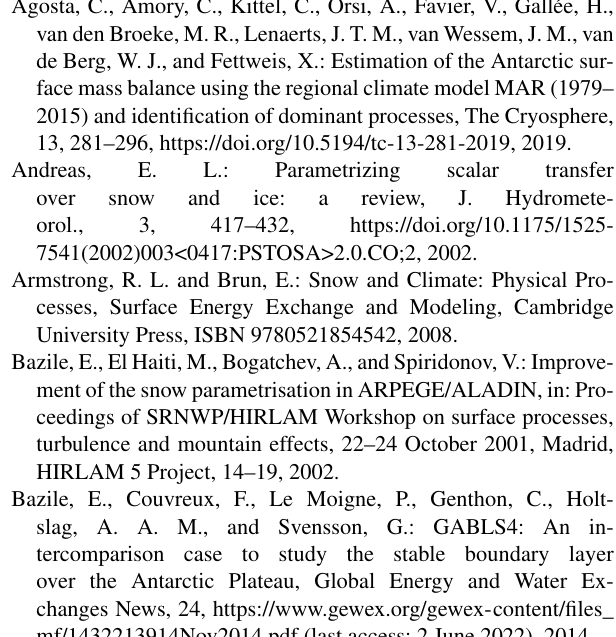
Figure A1 highlights the principle of the observed tempera- ture reconstruction